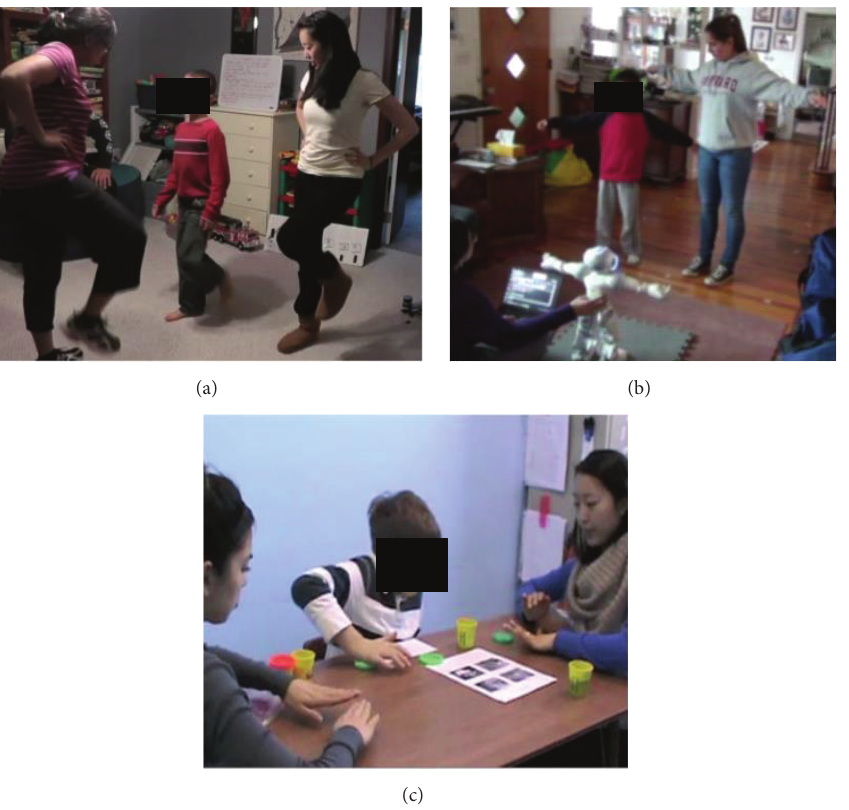
Figure 2: (a) Experimental set-up for a rhythm group training session. (b) Experimental set-up for a robot group training session. (c) Experimental set-up for a comparison group training